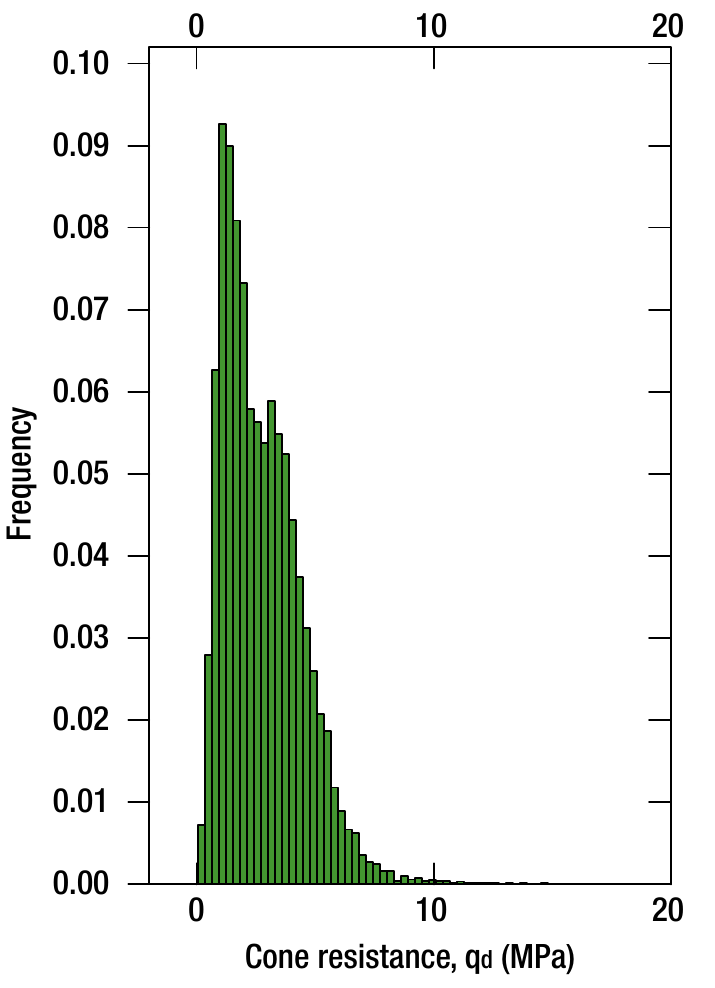
Figure 5. Histogram of q d values. Full survey grid.